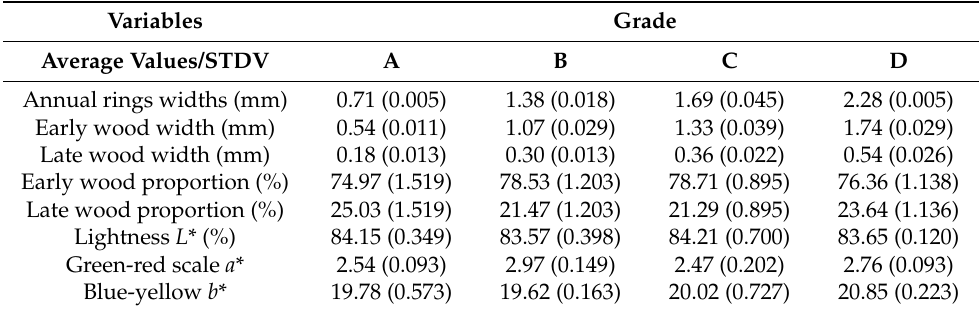
Table 2. The anatomical features of spruce wood studied samples (legend: the first value represents the average, and the value in parentheses represents the standard deviation).